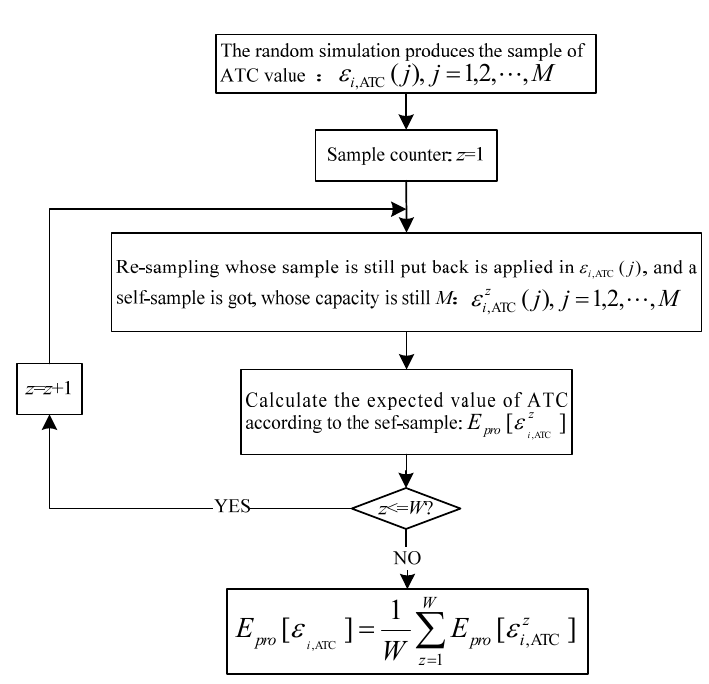
Figure 2. The flowchart of the bootstrap